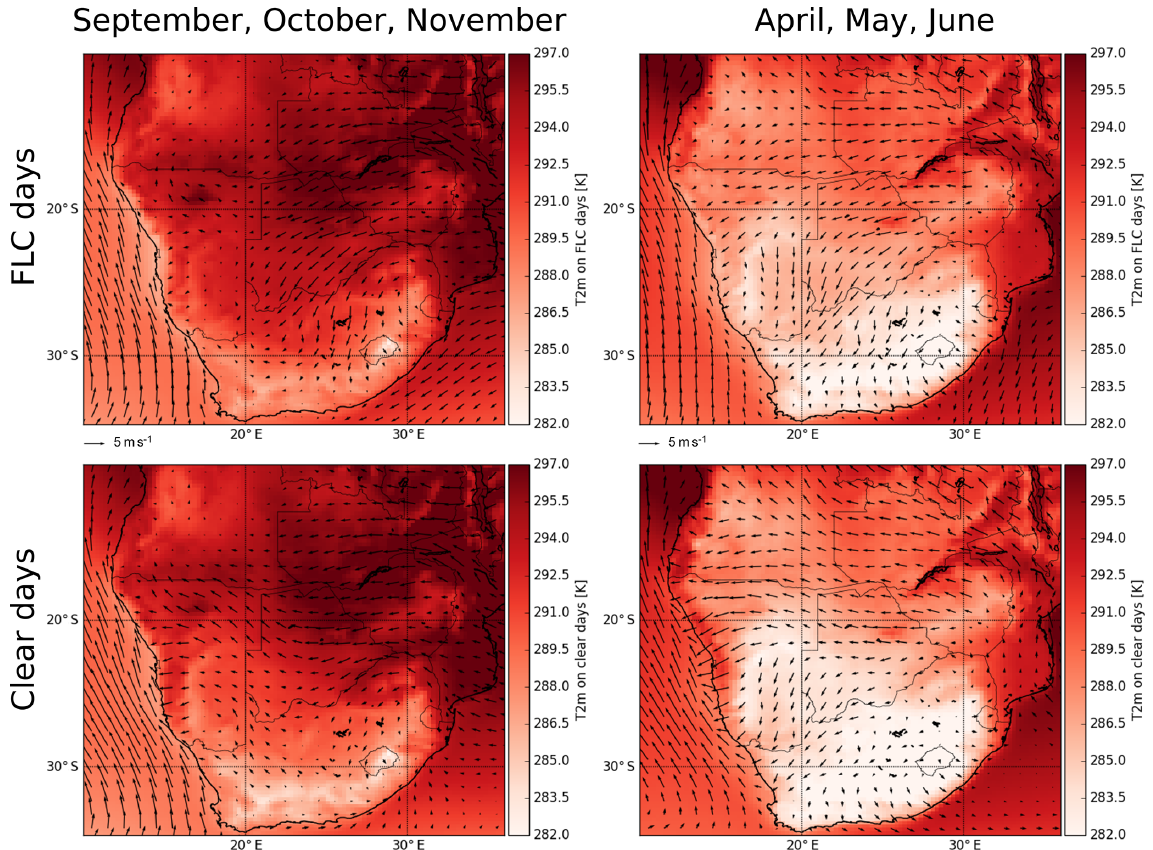
Figure A2. Seasonal average ERA5 T2m and 10m winds in SON (left-hand panels) and AMJ (right-hand panels) for FLC (top) and clear (bottom) days. Winds are averaged to a 1 ◦ × 1 ◦